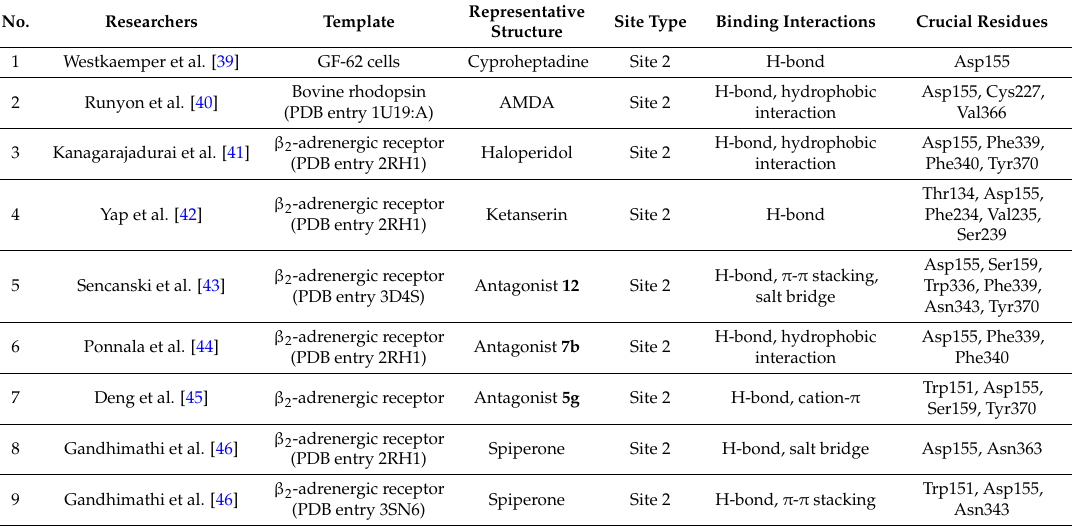
Table 2. The summary of various ligand-5-HT 2A receptor docking